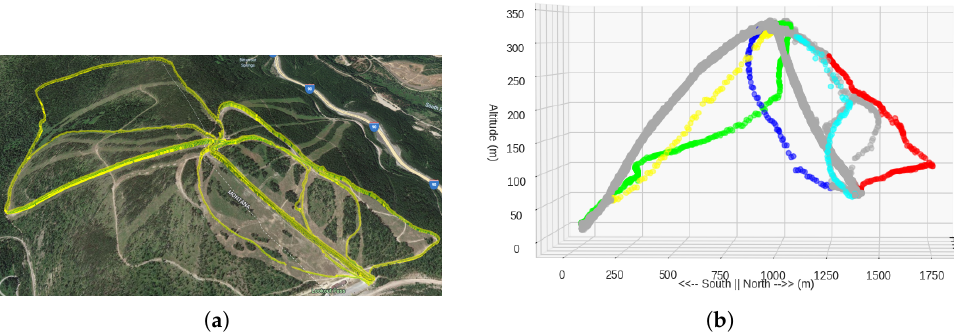
Figure 9. Inertial measurement unit WBAN ski motion sensor parts. ( a ) Day 1 GPS data rendered in Google Earth. ( b ) SkiMon GPS data for runs #1 through #5 on day 1. Each run is a different color, while all non-run data are in